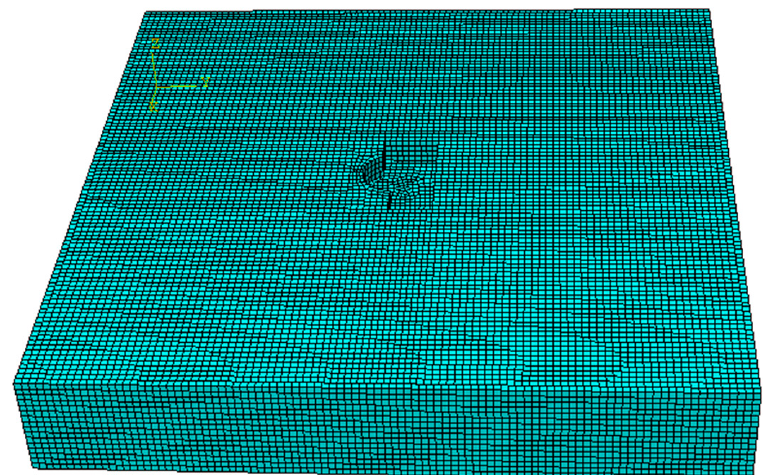
Figure 2. Finite element model of the raft